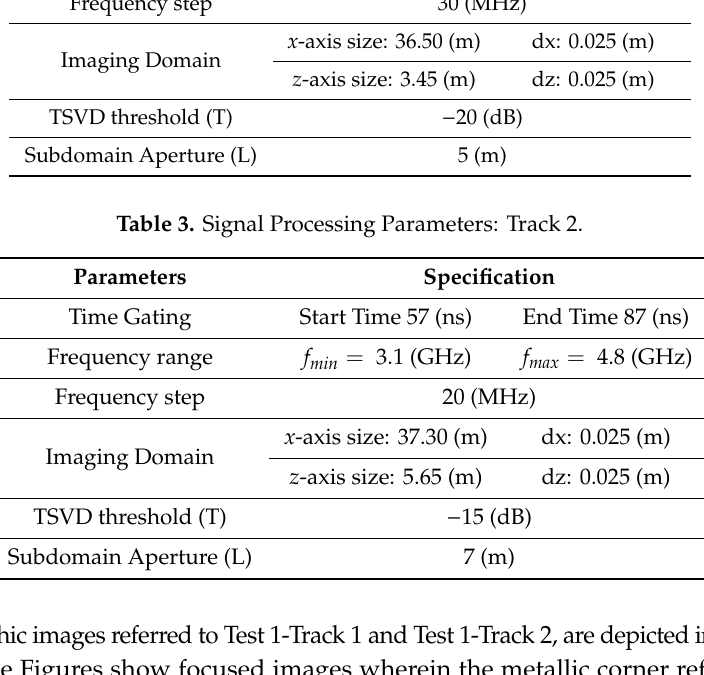
Table 3. Signal Processing Parameters: Track 2.